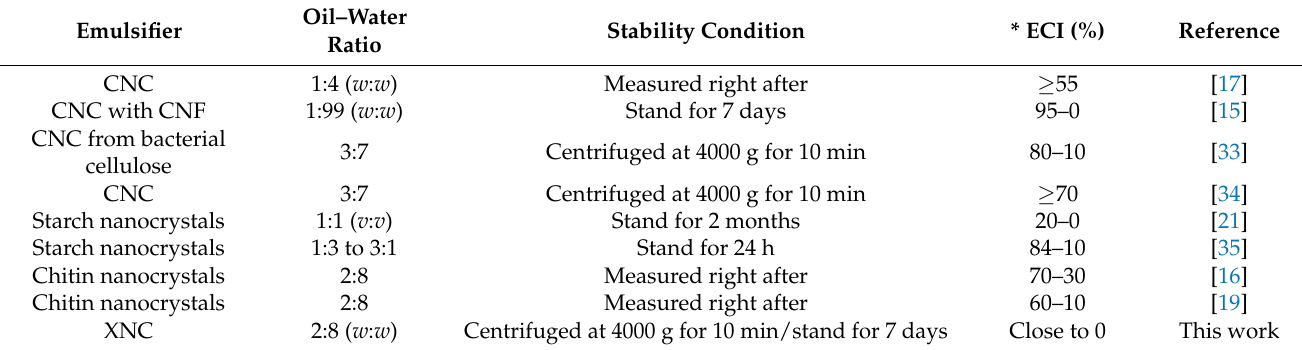
Table 4. Comparisons with other natural polysaccharide nanocrystals in the Pickering emulsion.